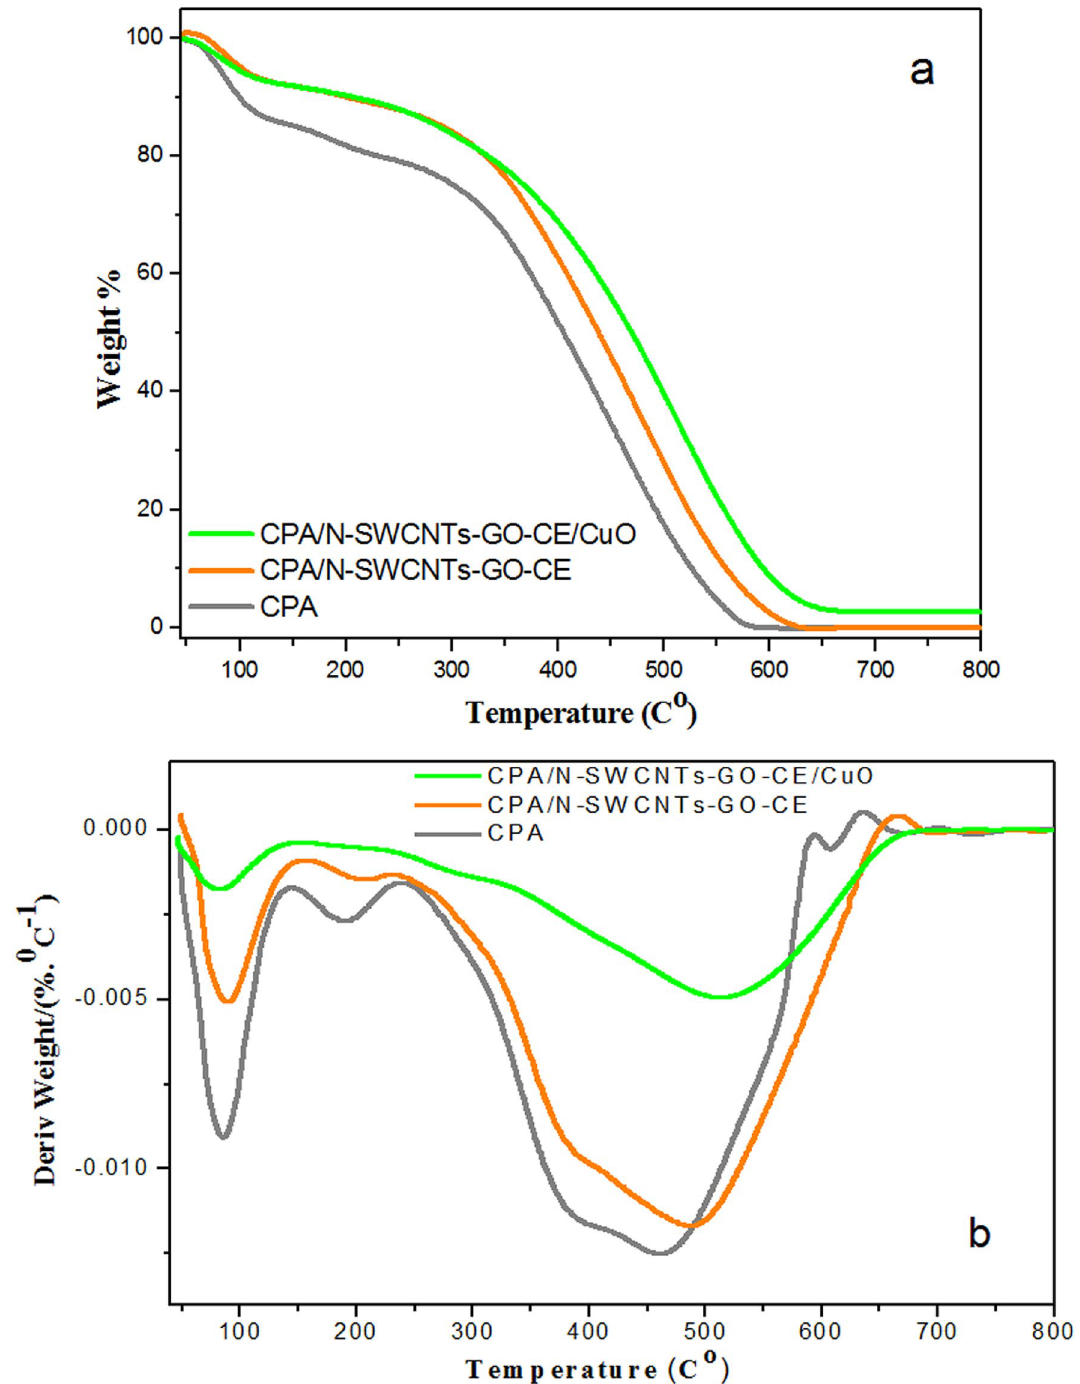
Figure 4. ( a ) TGA curves for pure CPA, CPA/N-SWCNTs-GO-CE and CPA/N-SWCNTs-GO-CE/CuO nanocomposites. ( b ) DTG curves for pure CPA, CPA/N-SWCNTs-GO-CE and CPA/N-SWCNTs-GO-CE/CuO